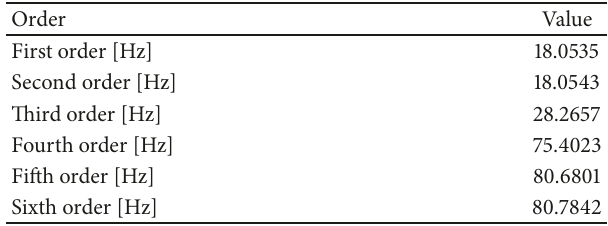
Table 10: The first six-order mode natural frequency of main blade.